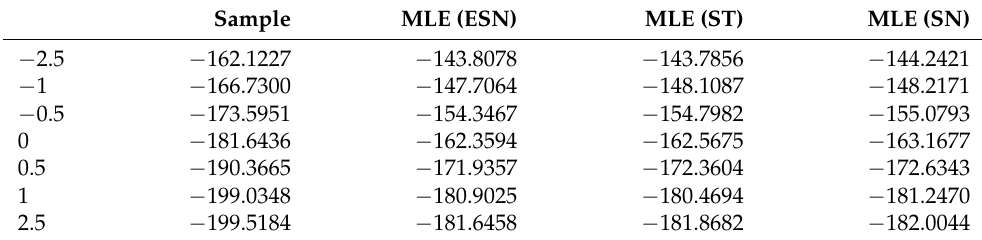
Table 14. Summary of estimated log-likelihood